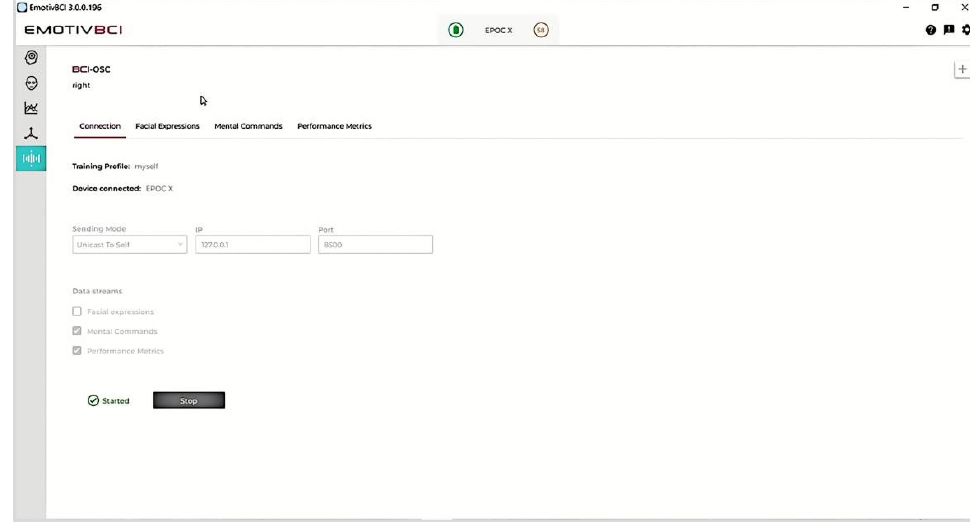
Figure 4. The data analysis software of EmotivBCI.